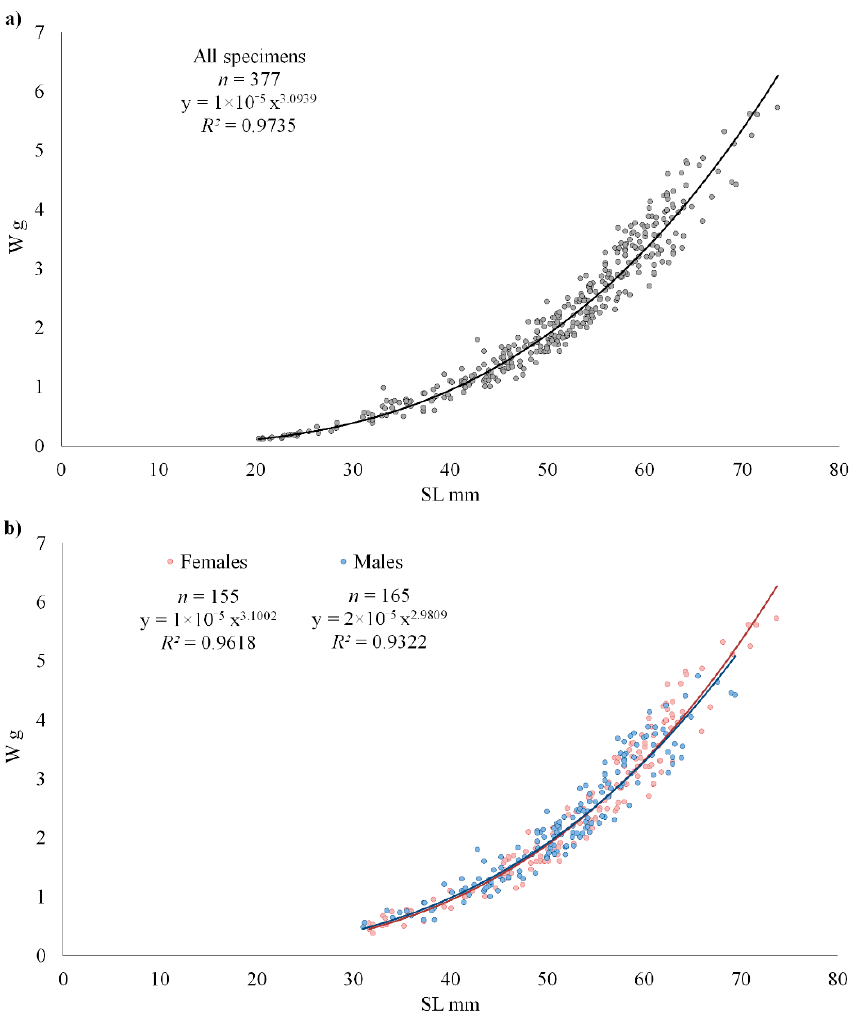
Figure 3. Length-weight relationship for total individuals ( a ), males and females ( b ) of Myctophum punctatum.